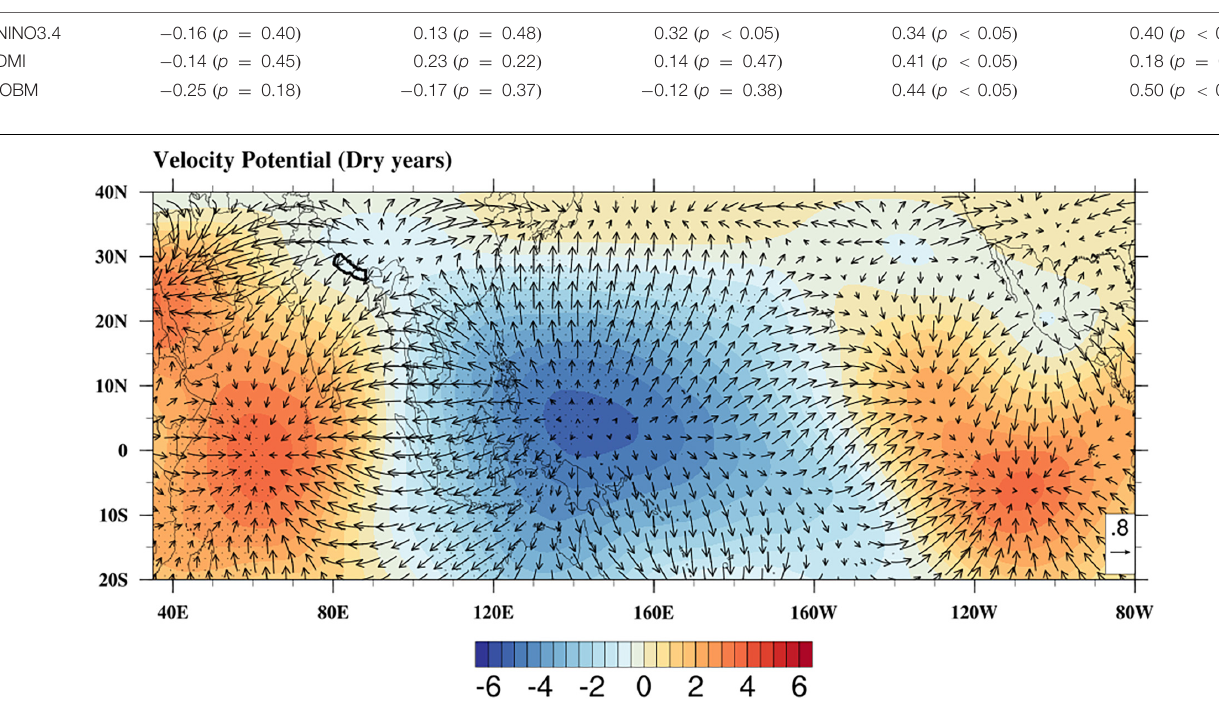
FIGURE 13 | 200 hPa divergent/convergent winds (vectors; m 2 s − 1 ) and velocity potential (contours; 10 − 6 , m 2 s − 1 ) for dry years based on ERA5 reanalysis data from 1987 to 2015. The dotted points represent the significance at a 95% confidence